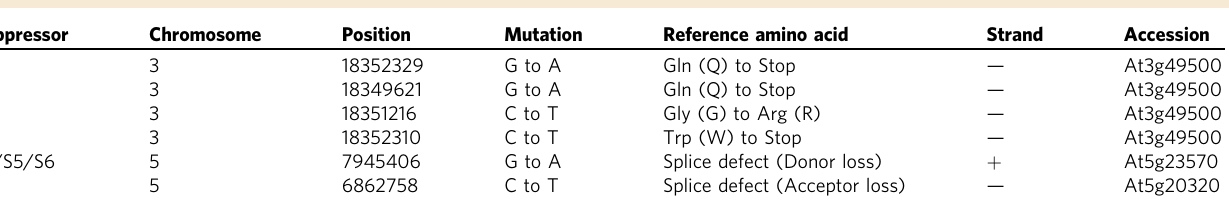
Table 1 Gene mutations underlying the tt19 suppressors.